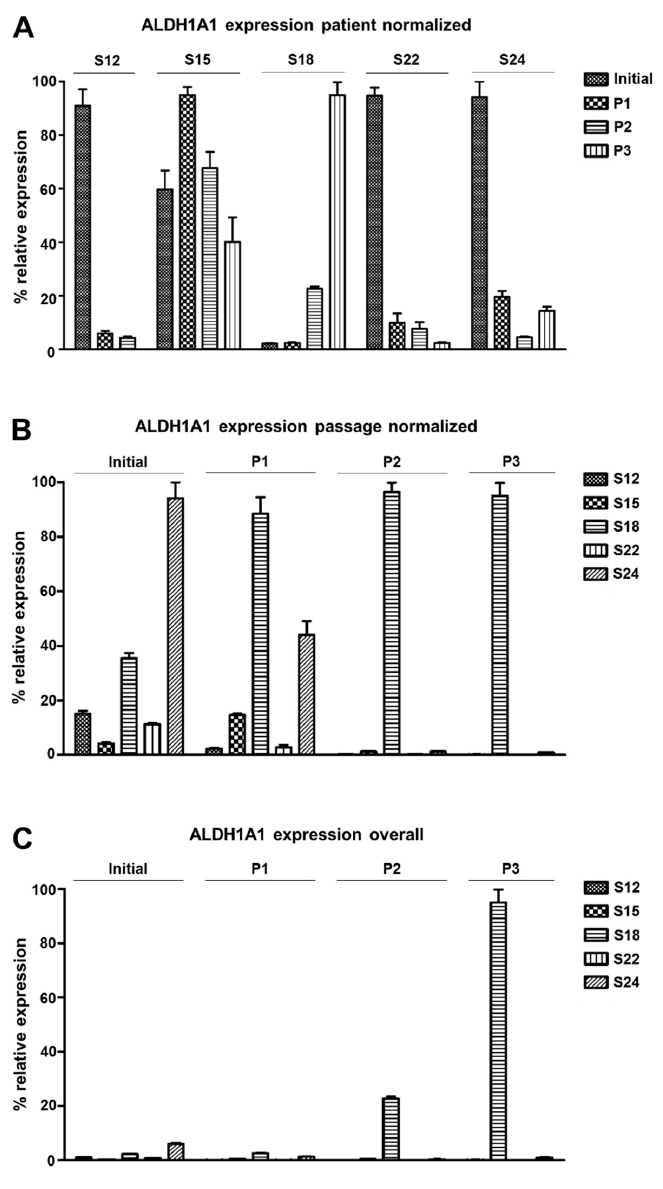
Figure 5. ALDH1A1 expression in primary HNSCC cell cultures in the initial tumor tissue and within the first three culture passages. ( A ) Relative expression (%) normalized by patient to compare ALDH1A1 levels relative to other cell entities of the same patient sample show higher ALDH1A1 levels in S18 cultures than in the initial S18 tumor. All other cultures showed lower or similar ALDH1A1 expression in comparison to the original tumor tissue. ( B ) Passage normalized data to compare ALDH1A1 levels between distinct patient samples within each passage and the initial tumors. Tumor sample S24 shows highest ALDH1A1 expression, whereas in cell culture cells of S18 overtop S24 cells form passage 1 on. ( C ) Data normalized to compare all samples of all passages and the initial tumor to each other reveals stark gradual enrichment of ALDH1A1 expressing cells in S18 cultures; P1 = passage 1; initial = original tumor tissue. 3.4. The Composition of HNSCC Cultures Can Be Accessed by Differential Marker Expression